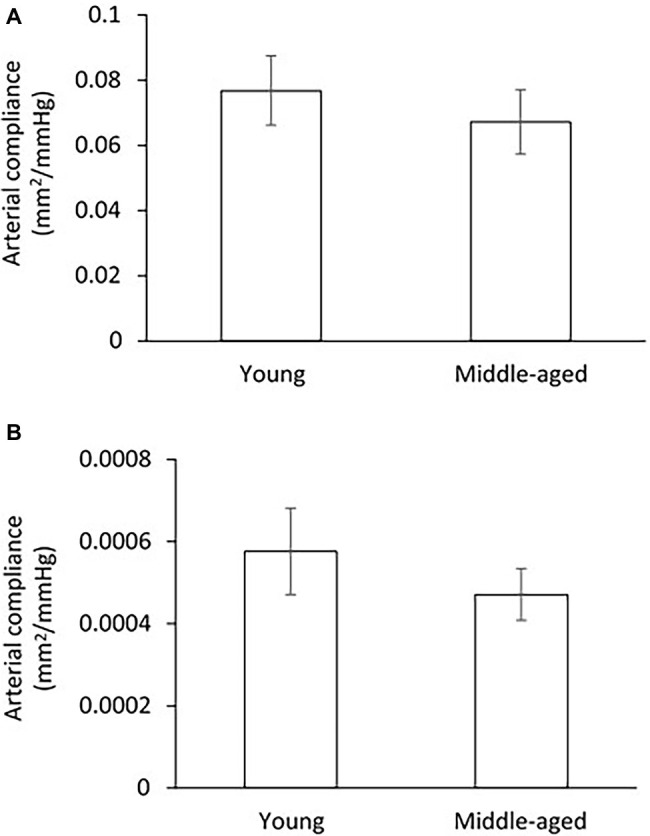
Comparison of arterial compliance for femoral artery (A) and small peripheral artery (B) between young and middle-aged pigs. Data corresponds to means ± SEM.